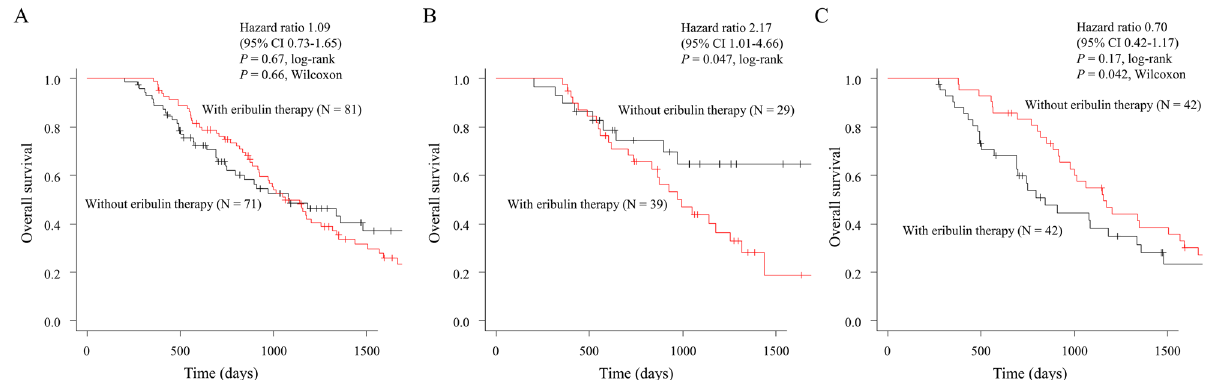
Figure 3. Overall survival with or without eribulin therapy in the overall longer time to treatment failure group ( A ), in the PB group ( B ), and in the non-PB group ( C ). CI confidence interval, HR hazard ratio, PB paclitaxel plus